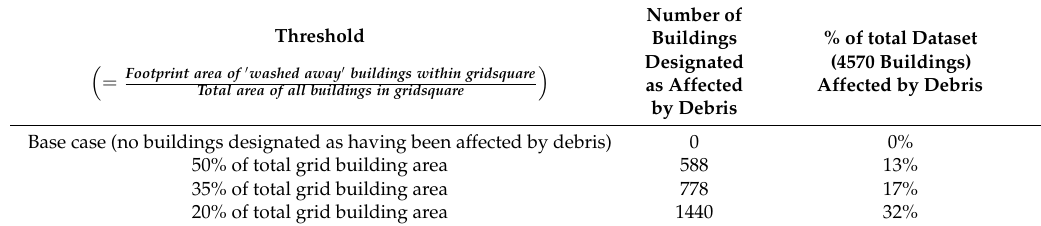
Table 2. Proportions of data designated as debris-affected under various collapse area